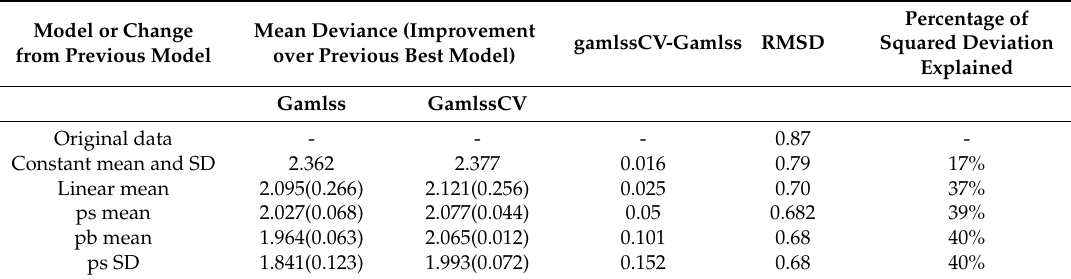
Table A2. Models of δ ln(chl) as a function of ln(chl SAT ), their mean deviance using gamlss and gamlssCV, and the percentage of squared deviation explained by the mean model. Model or Change from Previous